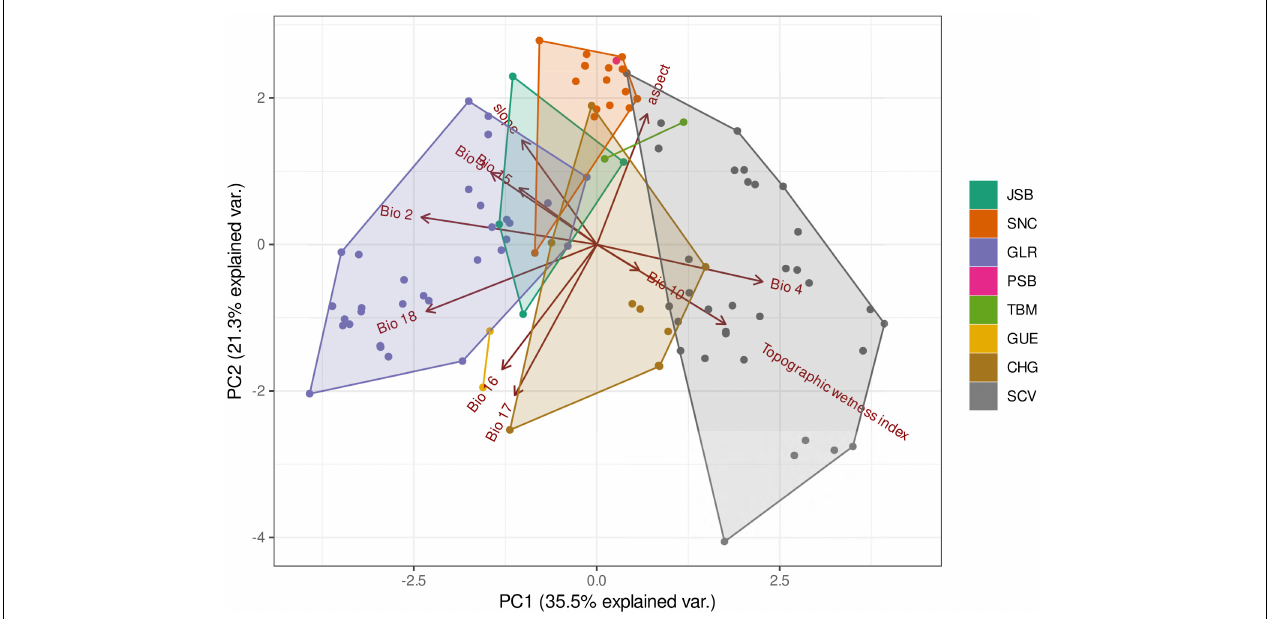
FIGURE 2 | Scatter plot of the principal components analysis (PCA) based on environmental space values occupied by Polylepis quadrijuga from Colombian Eastern Cordillera. Each different color dots represent the whole set of occurrences and the polygons highlight the occurrences superimposed to each Páramo complex. Niche area corresponds to the area of the hull relative to the largest polygon ( P. quadrijuga = 1).